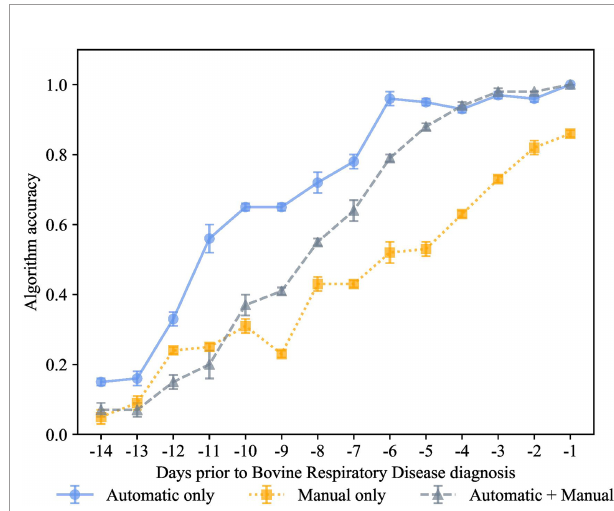
FIGURE 5 | K-nearest neighbor ’ s algorithm accuracy (mean ± SD) with 80% of training and 20% of testing from 10 runs of cross-validation for predicting calves destined for bovine respiratory disease diagnosis using automatically collected features by an automated milk feeder and accelerometer and manually collected features using outward clinical signs of bovine respiratory disease in a 106 dairy calf